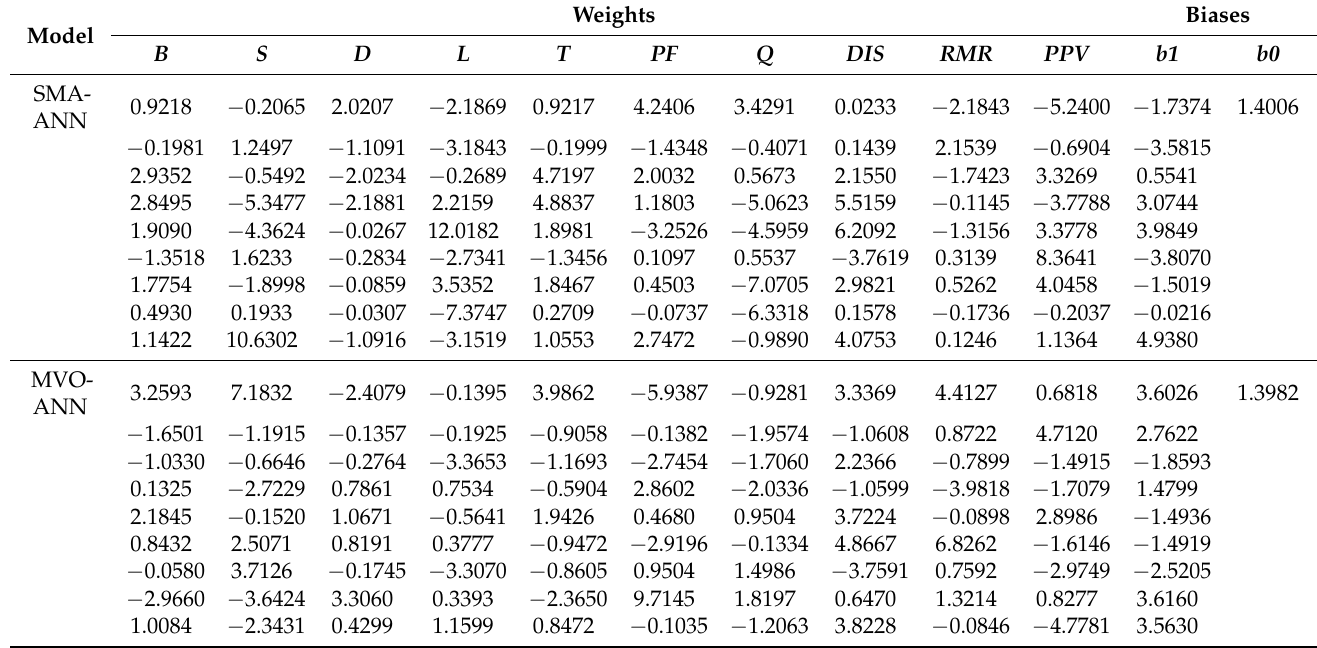
Table 4. Extracted weights and biases of the two optimized ANN